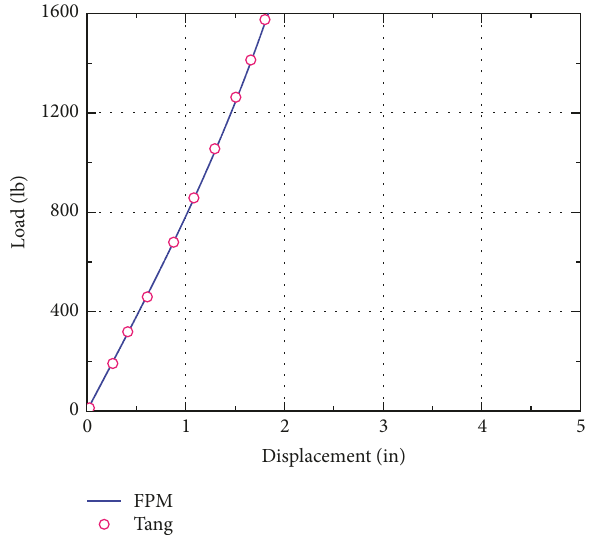
Figure 17: Load-displacement of beam free end (elastic-plastic).